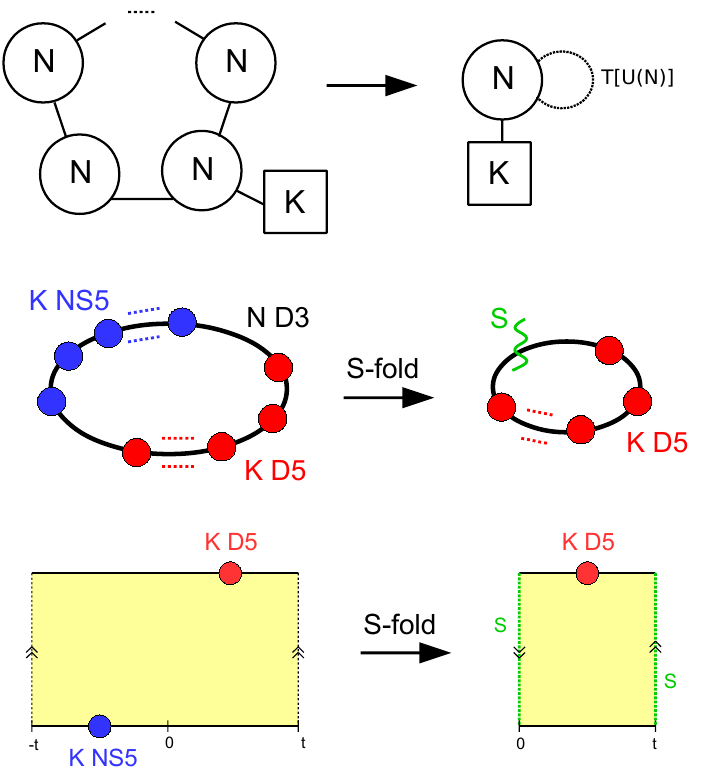
Figure 11 . S -quotient leading to the pure D5 theory. The double cover theory has K U( N ) nodes and K fundamental hypermultiplets in one node. The double cover supergravity solution has single stacks of K D5s and K